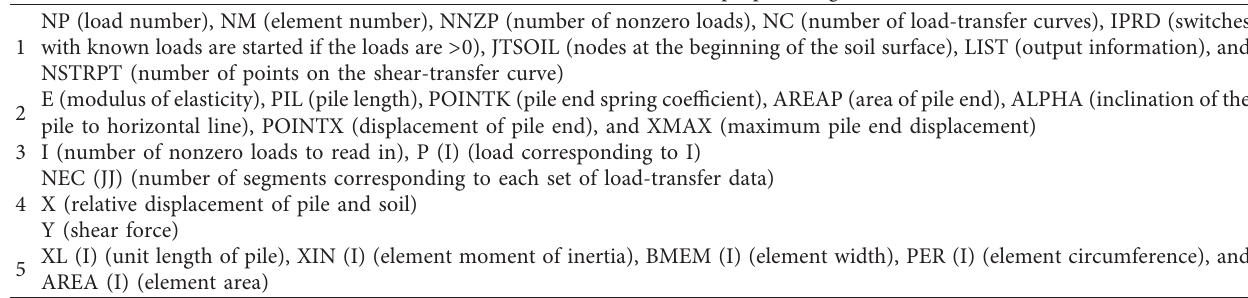
Figure 7: The algorithm proposed for calculating vertical bearing capacity of prestressed concrete pipe piles. Table 2: Parameters calculated via the proposed